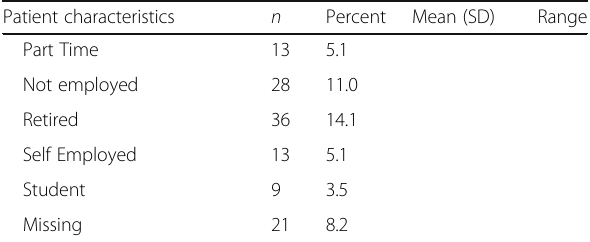
Table 1 Demographics of